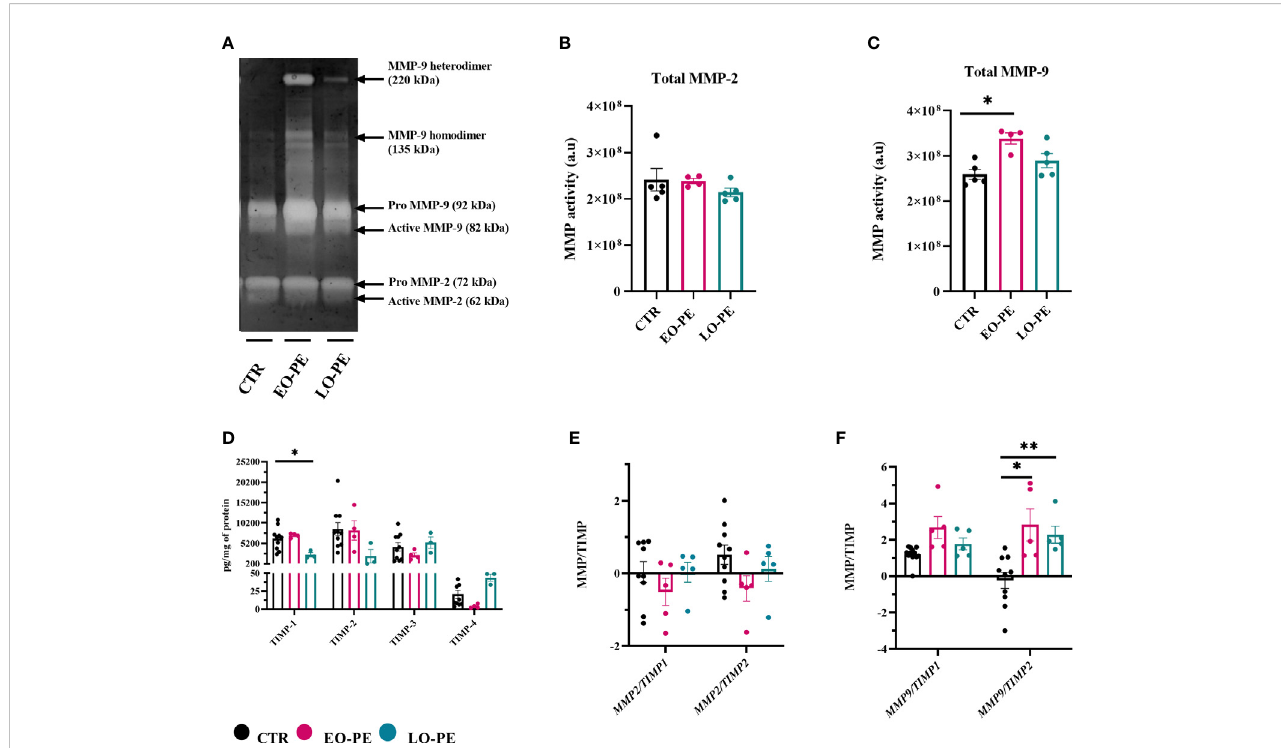
FIGURE 5 Gelatin zymography demonstrating gelatinolytic activity of HBCs. (A) A representative zymogram gel showing MMP-9 and MMP-2 activity of CTR (n=5), EO- (n=4) and LO-PE (n=5) HBCs. Activity was examined in the supernatants collected from CTR and PE HBCs on the 5th day post isolation. In total 15µg of protein measured in supernatants were loaded onto gelatin gels, respectively. To generate the comparable gelatinolytic bands, gelatin zymography was repeated twice. White bands of gelatinase activity observed at 92 and 82kDa are pro- and active form of MMP-9. Moreover, white bands at the size of 72 and 62kDa represents pro- and active form of MMP-2. Quanti fi cation of total (pro and active) form of MMP-9 (B) and MMP-2 (C) was performed as densitometric analysis of respective bands. (D) TIMP-1, TIMP-2, TIMP-3 and TIMP-4 levels measured in the cell culture supernatants using multiplex assay. In total CTR (n=10), EO- (n=4) and LO-PE (n=3) HBCs were used in technical duplicates. Secretion of respective TIMPs was normalized to the total protein content measured in the cell culture supernatants. (E) mRNA ratio between MMP2 and TIMP1 and TIMP2 . (F) mRNA ratio between MMP9 and TIMP1 and TIMP2 . mRNA ratio was calculated from the -ddCT values normalized to the corresponding housekeeping genes ( 18S , RPL30 and HRPT1 ). The results are showed as a mean ± S.E.M of technical triplicates. Statistical signi fi cance was assessed using ANCOVA with adjustment for gestational age followed by Sidak ’ s post-hoc test. *p ≤ 0.05. **p ≤